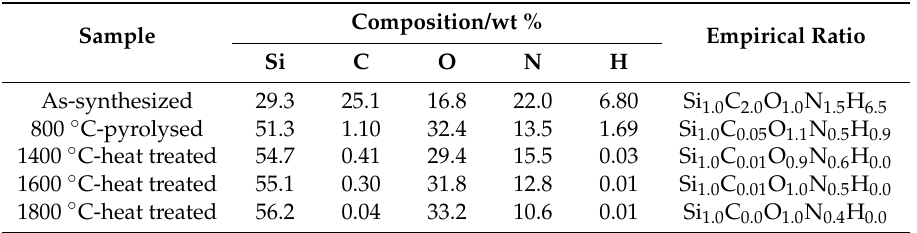
Table 1. Composition change of EtOSZ through 800 °C-pyrolysis and subsequent heat treatment up to 1800 °C in N 2 . Composition/wt % Sample Empirical Ratio Si C O N H As-synthesized